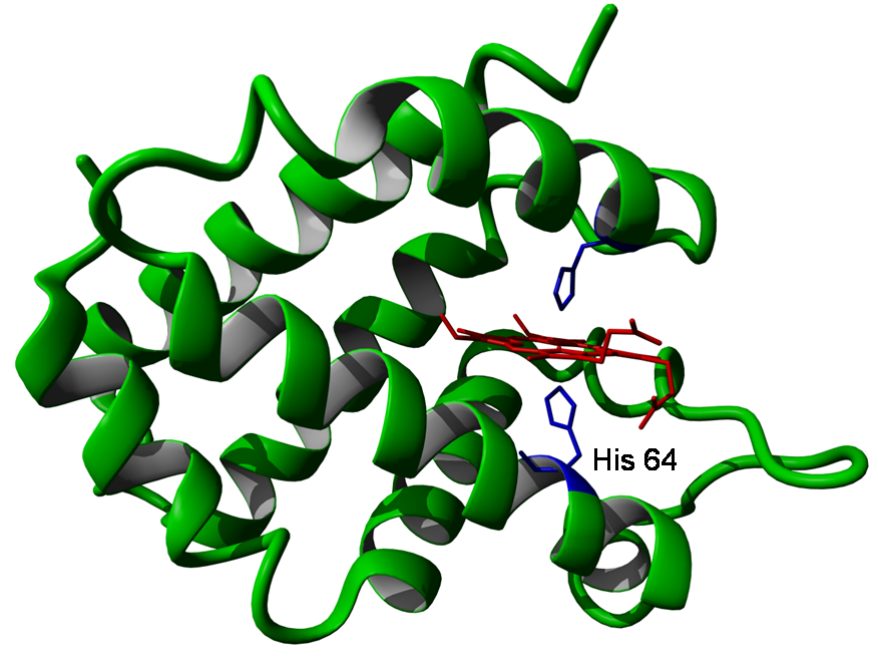
Figure 1. Crystal structure of human neuroglobin showing the heme group (red) and iron bound histidine side chains (blue). The partially dissociated histidine 64 is